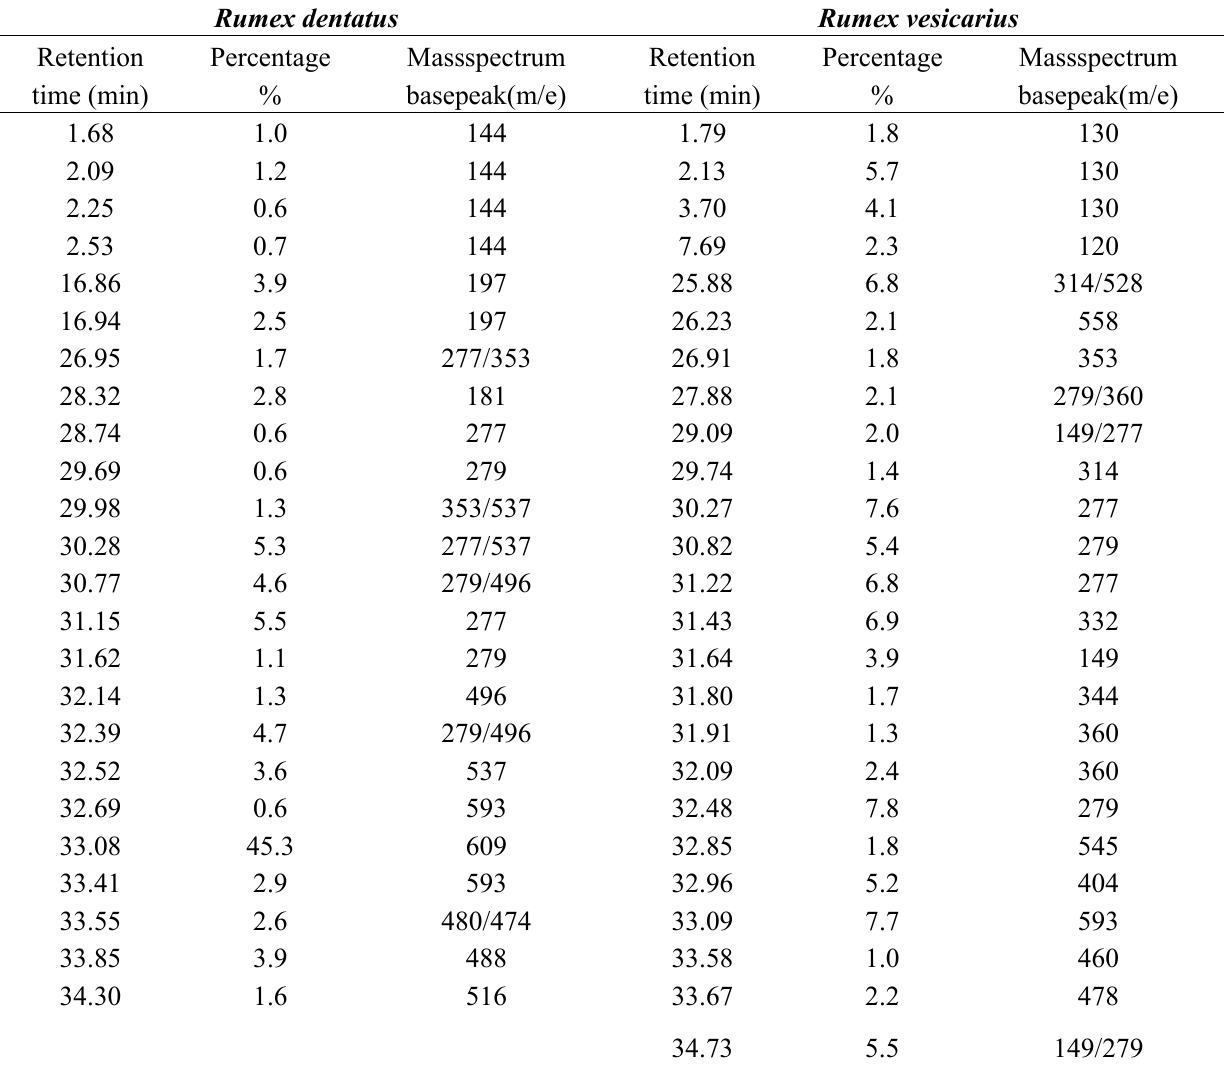
Table 3. Composition of the crude extracts of Rumex dentatus and Rumex vesicarius as analyzed by ESLCMS in the positive mode.